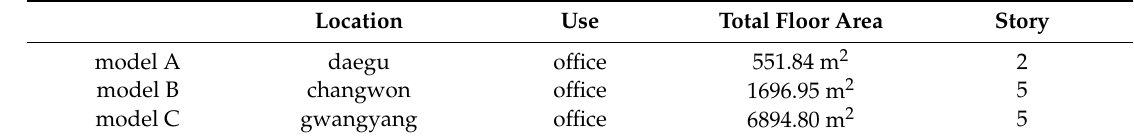
Table 1. Simulation models information.